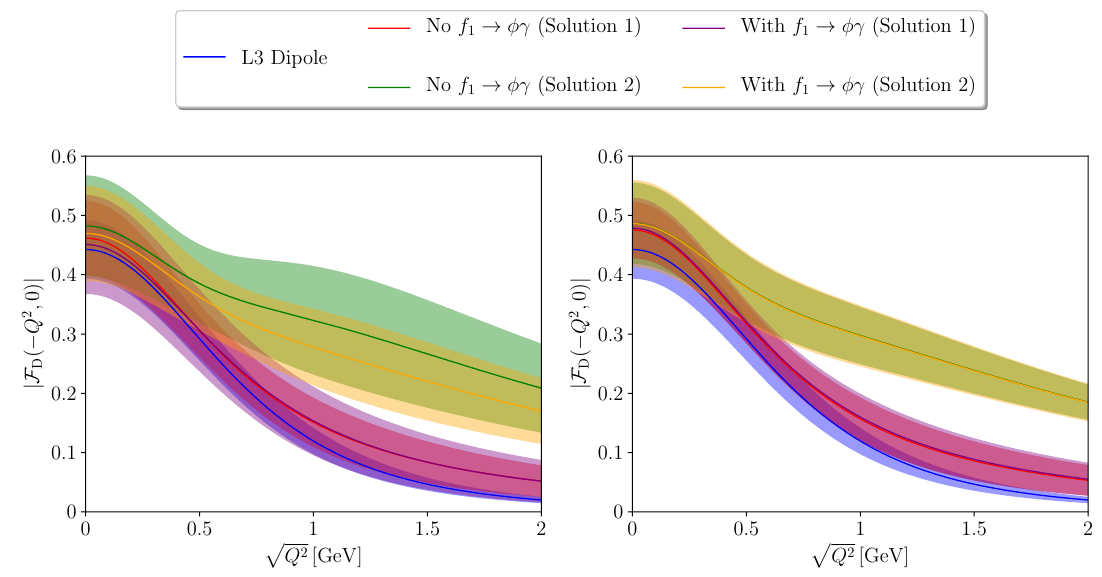
Figure 13 . Comparison of the fit solutions for the effective form factor probed in e + e − → e + e − f 1 to the L3 measurement [7], according to equation (4.11), for the minimal VMD representation ( left ) and the extended one ( right ). The L3 dipole band includes the uncertainties on |F D (0 , 0) | and Λ D as given by equation (4.2), added in quadrature; ours propagate the uncertainties from table 8 and table 9,